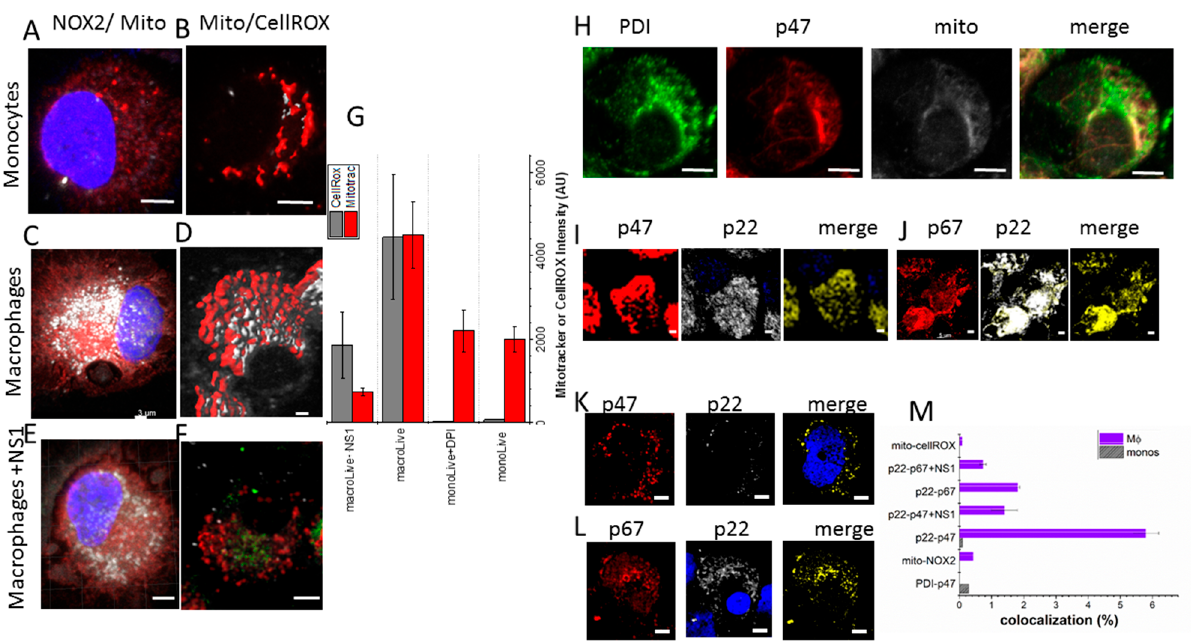
Figure 3. Confocal imaging of living cells (Left A – F) ( A , B ): monocytes isolated from blood of healthy donors; the red signal is the NOX2 and mitotracker in ( A , B ), respectively, the grey signal corresponds to the mitotracker and CellRox deep red reagent in ( A , B ), respectively; ( C , D ) Monocyte-derived macrophages (with CSF1-without NS1 treatment) using the same markers used for the living monocytes in ( A , B ); ( E , F ) the macrophages were treated with NS1 after their CSF1-induced differentiation from monocytes using the same markers as in ( A , B ); the green signal in ( F ) is the fluorescence of NS1; the ROS levels are quantified by the cell-permeable CellROX deep red reagent shown in light grey, the mitochondria are monitored by the red mitotracker reagent as quantified in ( G ); Co-localization experiments in fixed cells (Right H – L) The images ( H – L ) present co-localization experiments in fixed monocytes or CSF1-treated monocytes differentiated into macrophages . Each antibody is mentioned above each image, the merge, representing the colocalization is shown in yellow. The intensity of the colocalization is quantified in ( M ). We tested colocalization between partners of the activated NOX2 complex in “M2” macrophages formed by membrane bound NOX2 and p22 phox with p67 phox and p47 phox (p40 phox and rac1 are not labeled). It is known that p67 phox and p47 phox are located in the cytoplasm of the resting cells [23] in agreement with the images shown in ( H ); ( I , J ) are p22 phox -p47 phox and p22 phox -p67 phox co-localization signals in macrophages without NS1, respectively; ( K , L ) are p22 phox -p47 phox and p22 phox -p67 phox co-localizations with NS1, respectively. Scale bars are 3 µ m. Quantification of the 3D images is shown in ( M ) and was performed with Imaris 7.3 software (http://www.bitplane.com/imaris, accessed on 6 February